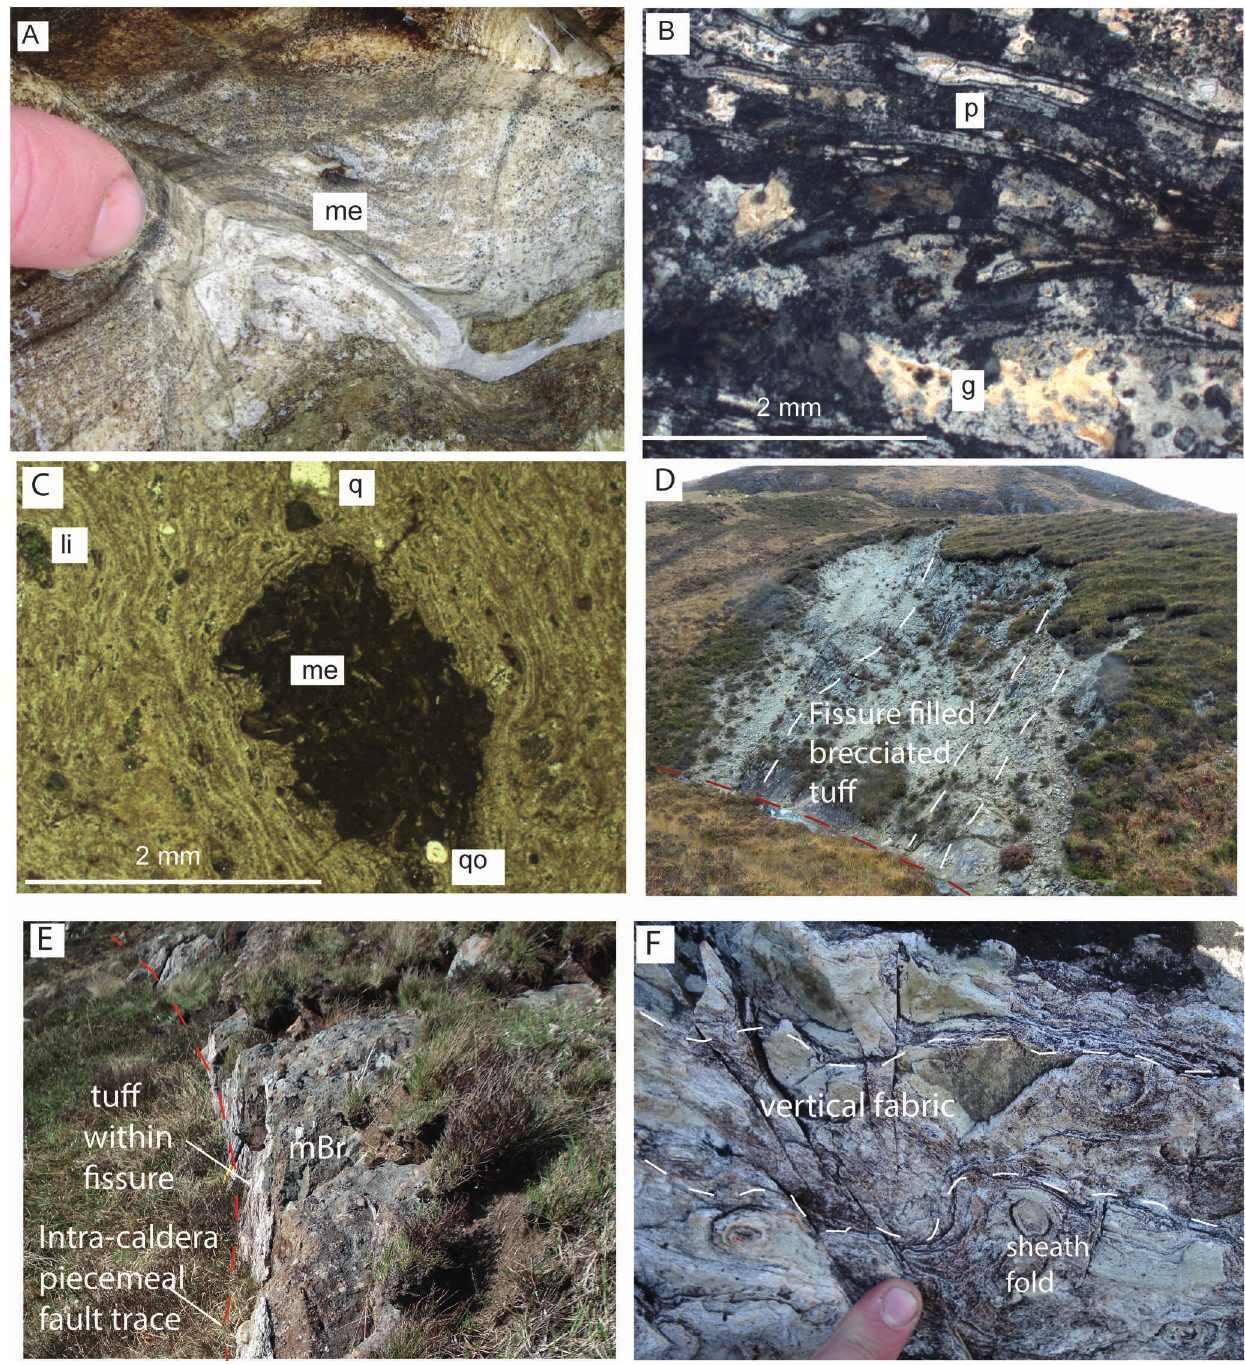
Figure 8: Field and petrographic characteristics of lava-like ignimbrite (mLT lava-like) and tuff filling fissures (TFF). [A] mLT lava- like, (log 18, 318 m height, see Supplementary Material 1). Note the dark and lighter coloured bands which reflect differences in mineral content (see Figure 8B), together with type II mafic enclaves (me), [Troll et al. 2004]. An orange weathered rind pervades to a depth of ≤ 2 mm. [B] XP image of parataxitic fabric (p) in quartz-rich recrystallised layers within mLT lava-like (log 18, 318 m height, see Supplementary Material 1). Note rod like terminations of parataxitic fabric, which appears as a series of rectangles. Undeformed glass shards (g), are evident in strain free regions (bottom middle). [C] PPL image of parataxitic fabric deformed around quartz (q), lithics (li), and type III mafic enclave (me), from log 18, 316 m height, (see supp file) in mLT lava-like. Late-stage quartz (qo) is seen overgrowing both mafic enclave and fabric. [D] Rhyolitic tuff filling a fissure with vertical fabric filling a 170 m long NNW-trending fissure in Allt Coire Forsaidh (log 12: Supplementary Material 1). Note near vertical fabric in tuff indicated by white hatched lines. [E] TFF. Rhyolitic tuff with vertical fabric filling a 170 m-long NNW-trending fissure (log 17: Supplementary Material 1). Note fault trace (red hatched line) which has offset fissure sidewall to produce step like profile. [F] TFF. Sidewall of fissure in [G], note the presence of vertical fabric (white hatched lines) and ubiquitous elliptical sheath